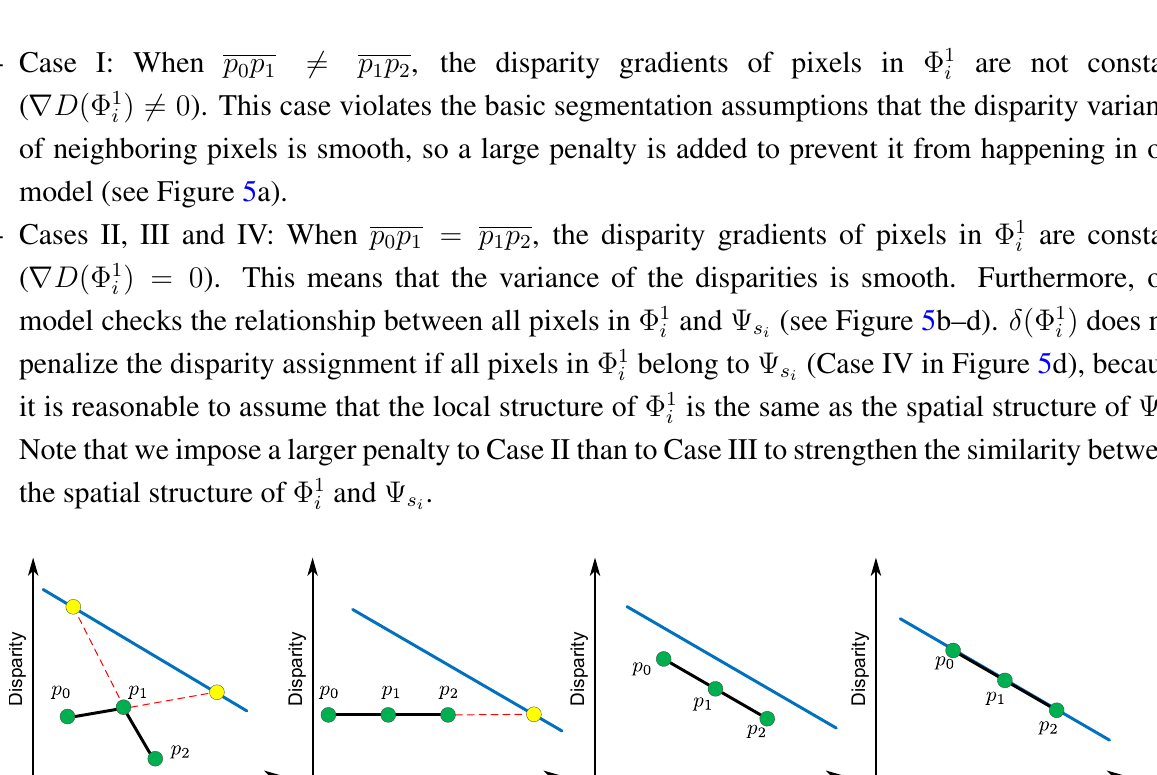
) with the i = { p , p , p } , under different disparity 0 1 2 i . Yellow nodes are i